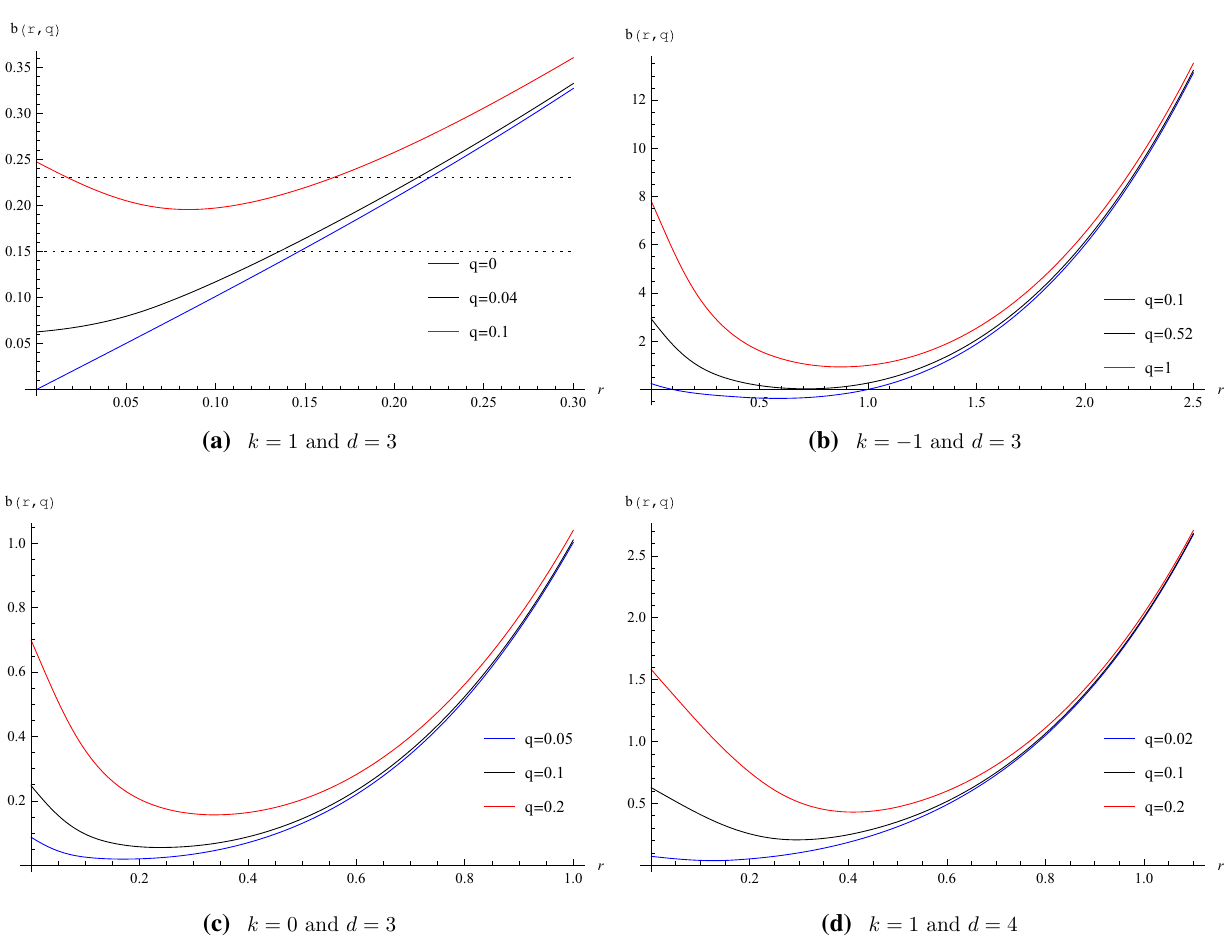
Fig. 1 Plots of b ( r , q ) versus r for different values of q , where L = 1 and β =